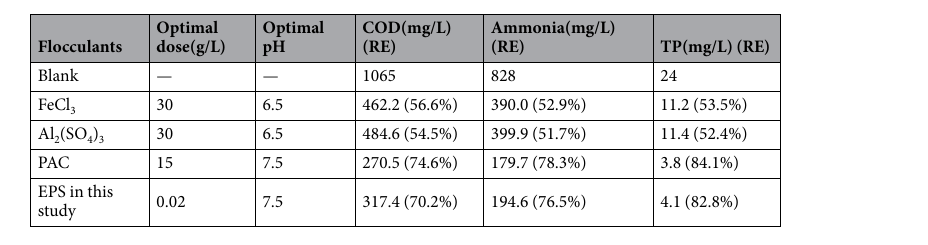
Table 1. Results of ADSW treatment by different